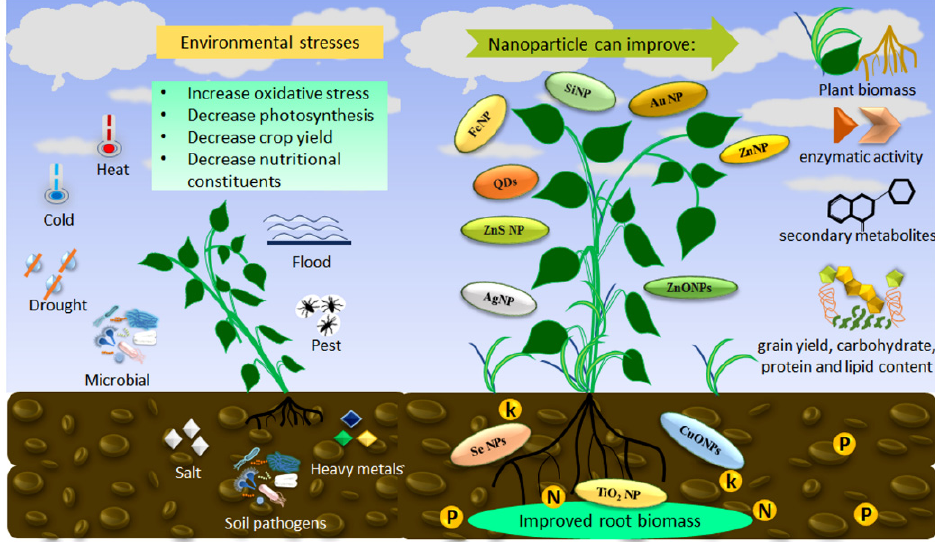
Figure 4. Overview of different environmental stresses and role of nanoscale materials to improve plant response.